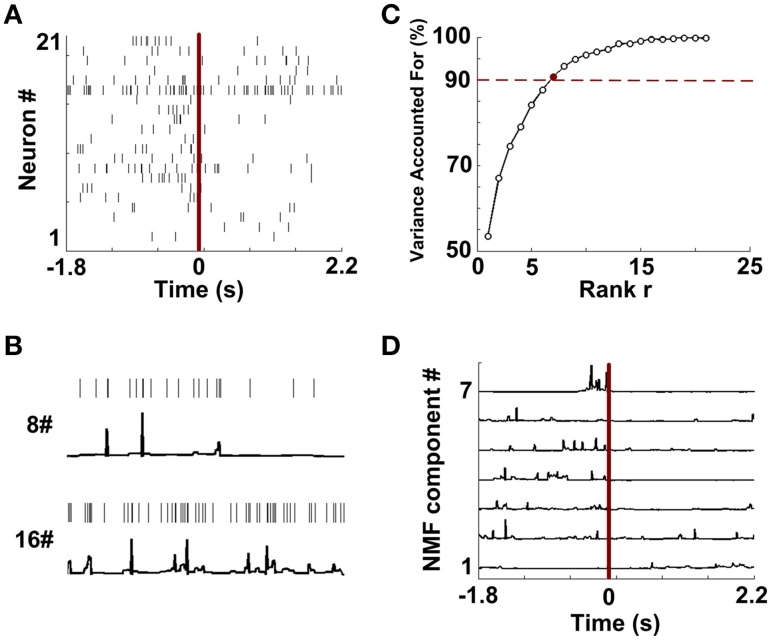
Data preprocessing and NMF component extraction. (A) The rastergram shows single-unit spike trains during a trial. (B) Two examples of constructions of continuous time series from discrete spike trains (Neuron 8 and 16 from A). (C) The percentages of Variance Accounted For with various number of rank r. Red dashed line means the threshold for VAF (90%). 7 (red point) is the optimized number of rank r in this trial. (D) NMF components extracted from the continuous series.